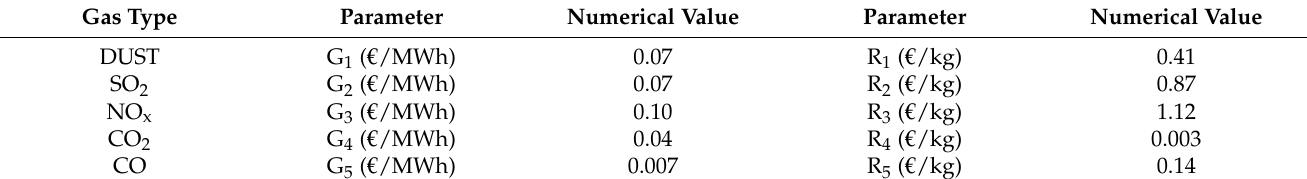
Table 5. Types of emissions and environmental costs.